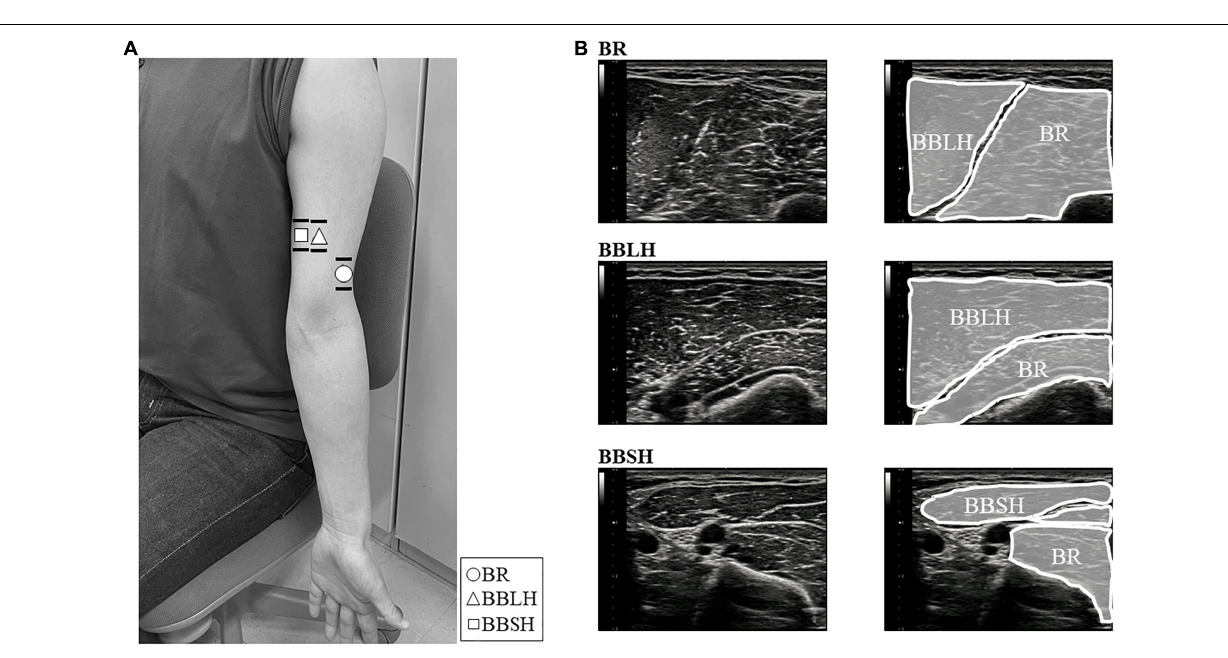
task. Elbow movements were detected using the radial and ulnar styloid process of their measured upper limb as anatomical bony markers, with the start and end times being identified based on the movements of these markers captured using a video camera. The start time was defined as the beginning of